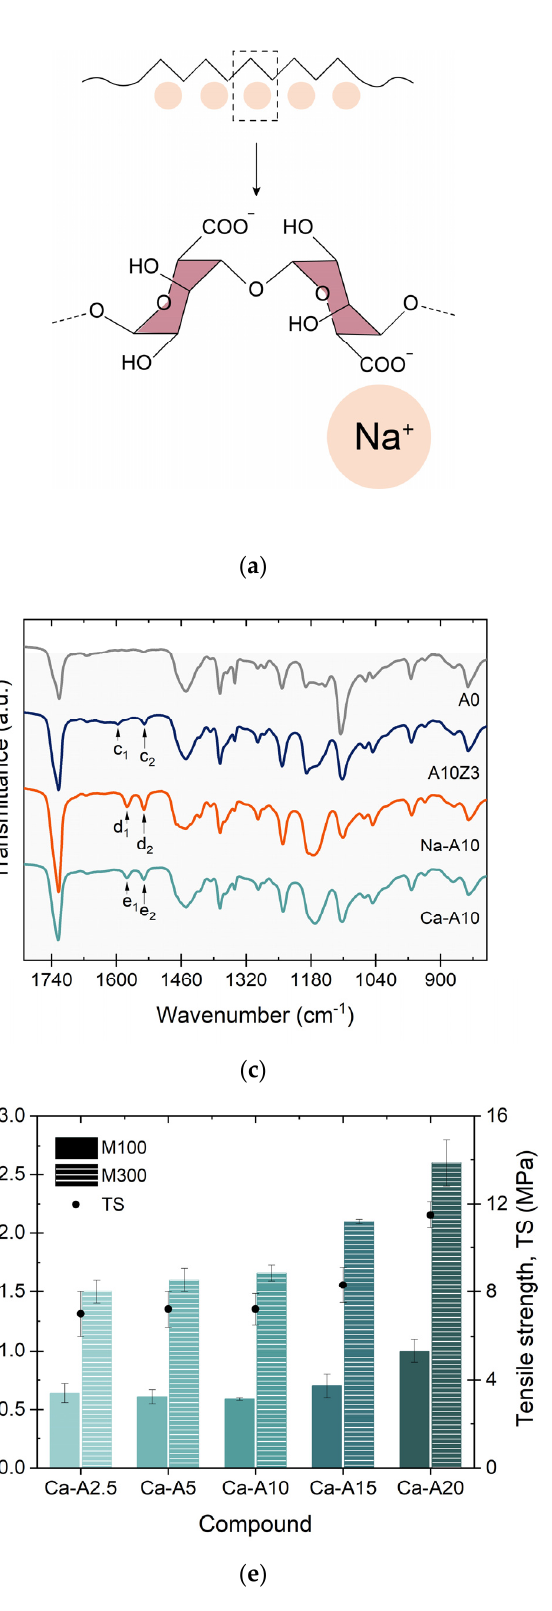
Figure 11. Model of the structures of ( a ) Na-A and ( b ) Ca-A. ( c ) Infrared spectra (ATR mode) of selected TPEs as a function of the cation involved, ( d , e ) tensile properties of Na-A- and Ca-A-based compounds, and ( f ) the best mechanical performance for each type of cation.